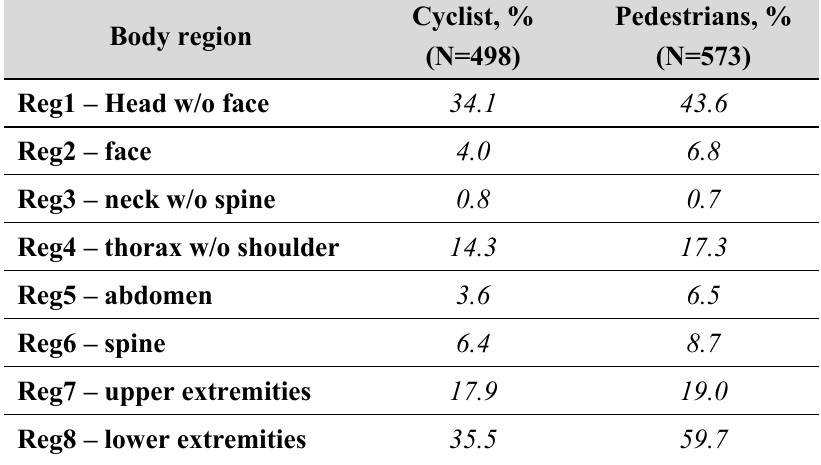
Table A6. Proportion of MAIS2+ injured cyclists and pedestrians sustaining MAIS2+ injuries from impact with the car in the listed body regions